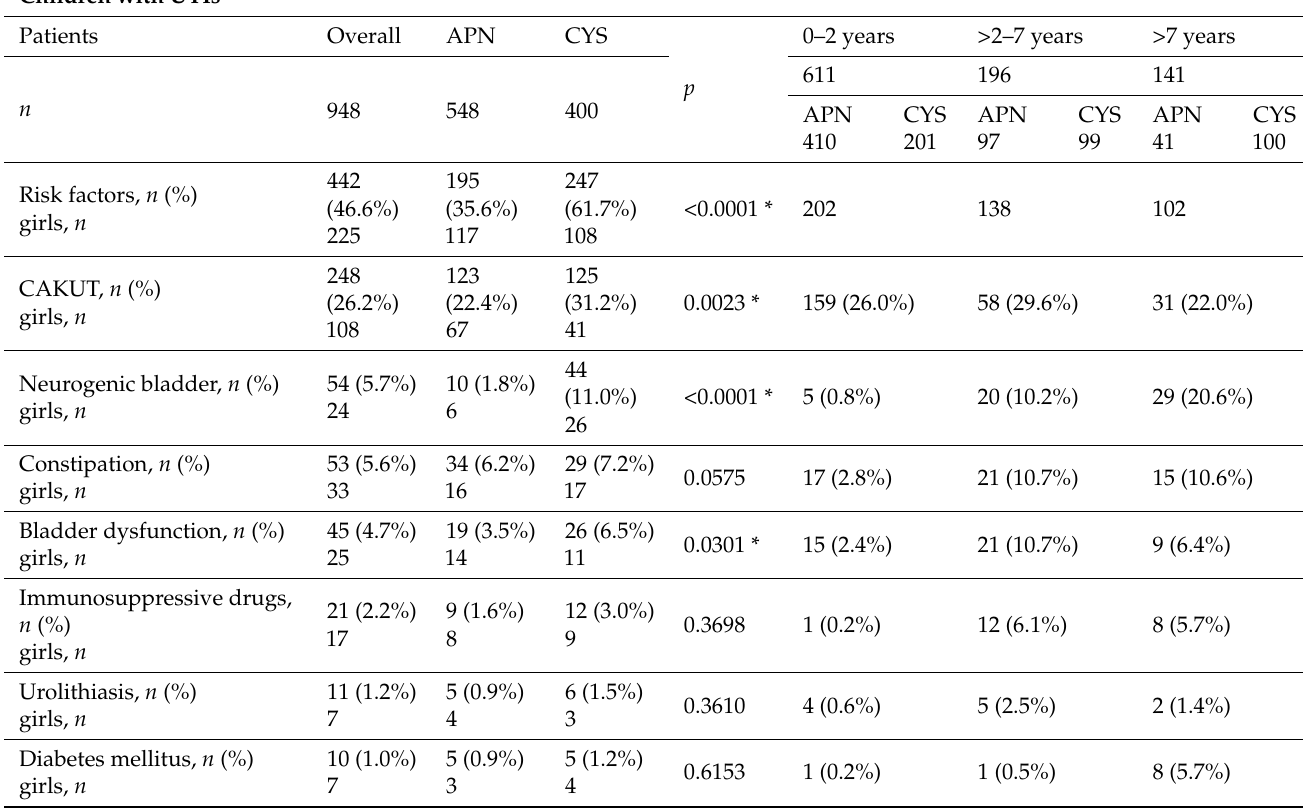
Table 2. Risk factors of UTIs in children, according to their clinical presentations (APN and CYS) and age